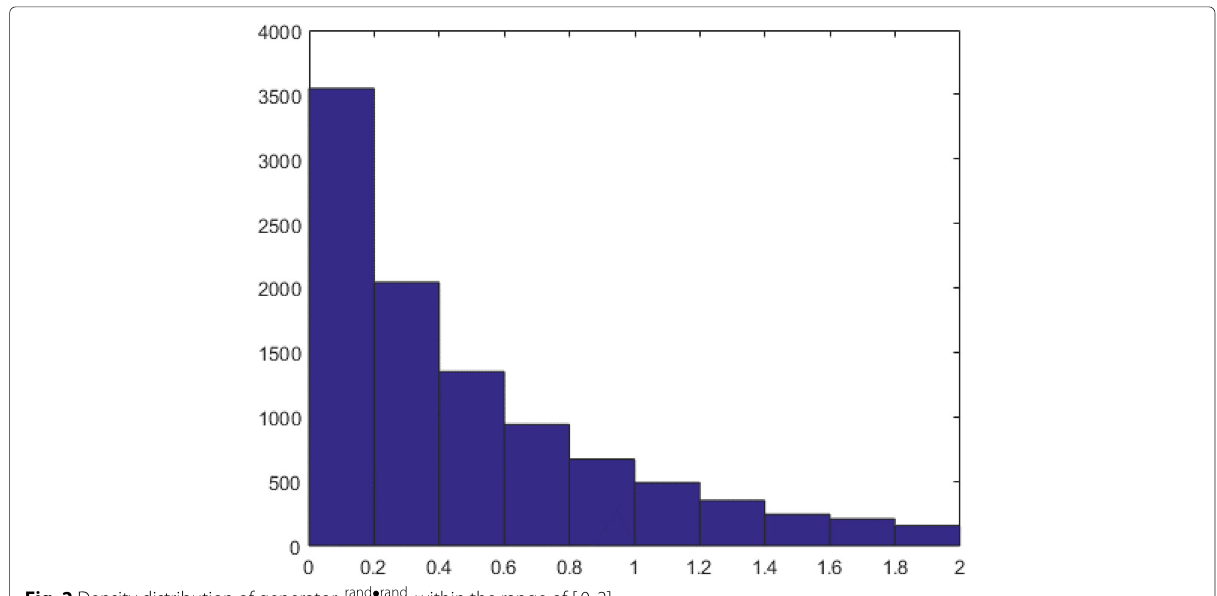
global best food source. If it is not the best food source, they will randomly select a neighbor r of the current food source i and decide if pbes t r is better than pbes t i . For Onlooker bees, they use the roulette wheel selec- tion mechanism to select a food source to exploit. The main pseudo code of ABCIS algorithm is presented in Algorithm